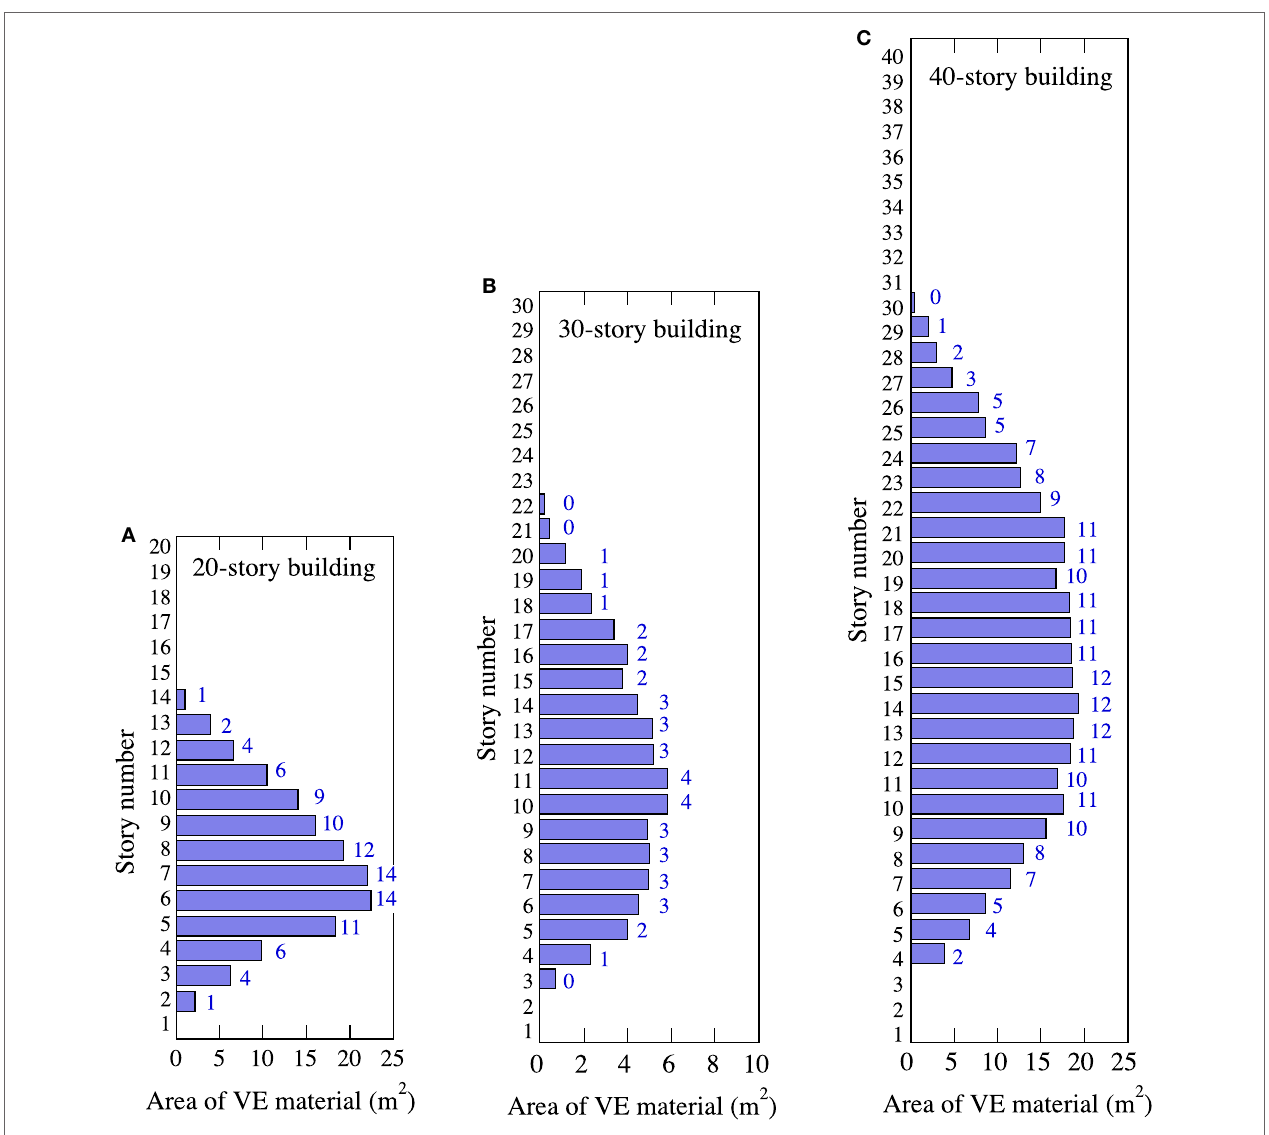
FIGURE 19 | Story-wise distribution of VE material area and necessary number of VEDs in 20-, 30-, and 40-story buildings designed for maximum story drift angle of 1/150 . (A) 20-story building, (B) 30-story building, and (C) 40-story building.